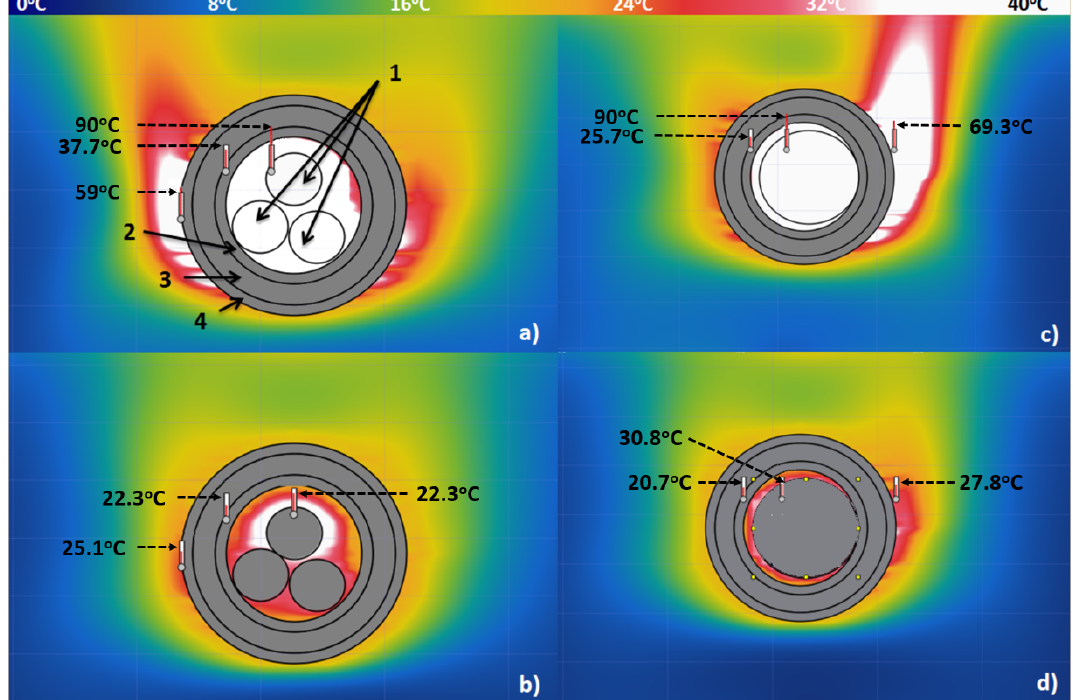
Figure 10. Simulation of thermal convection of two SMA-based actuators configuration [25]